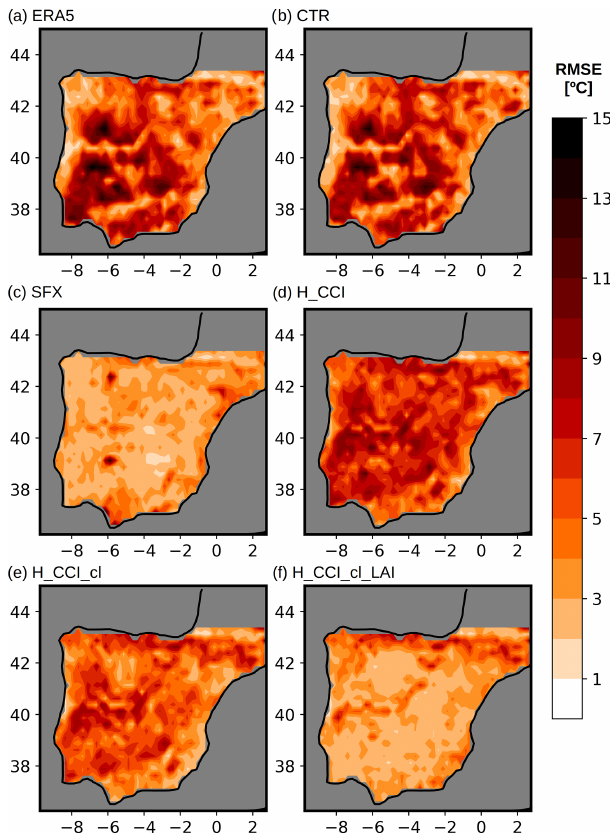
Figure 2. Same as Fig. 1 but for